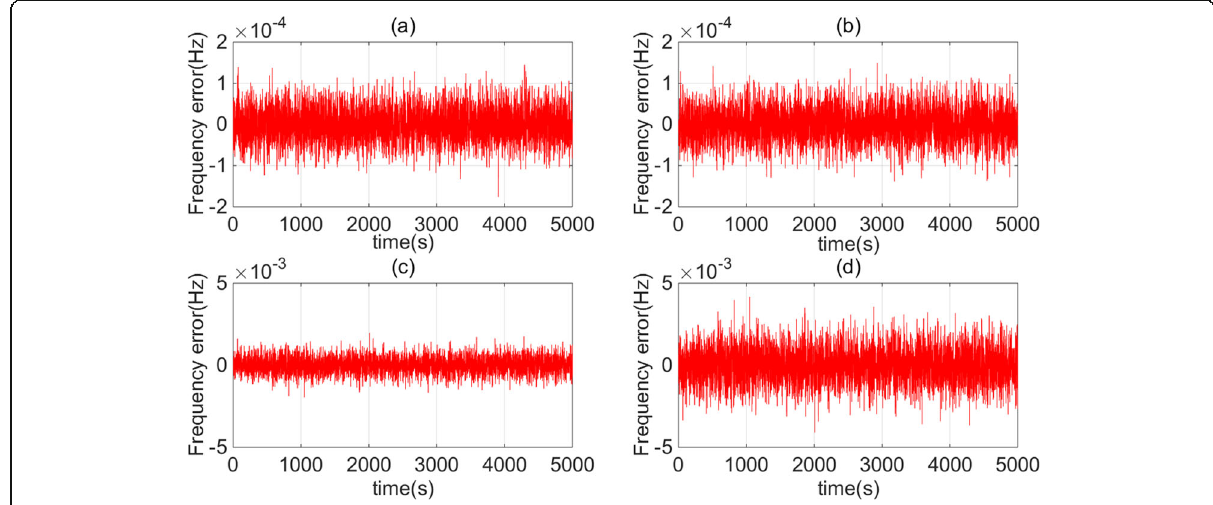
Fig. 9 Frequency transfer error curve under real conditions with observation